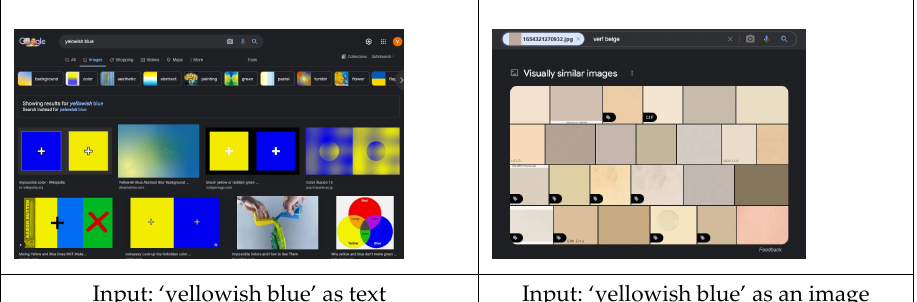
Figure 3. A variety of different beer colors and tea colors.